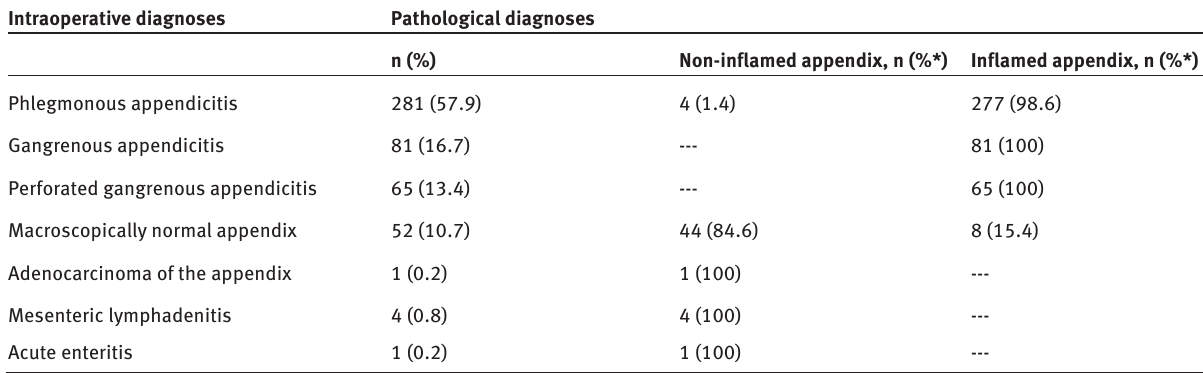
Intraoperative diagnoses